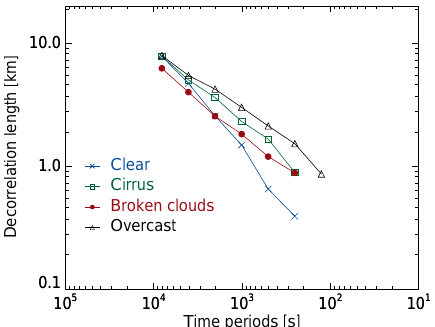
Figure 7. Decorrelation lengths a (in km), determined as e -folding time of the spatial correlation function, and its dependence on the time period of variations.